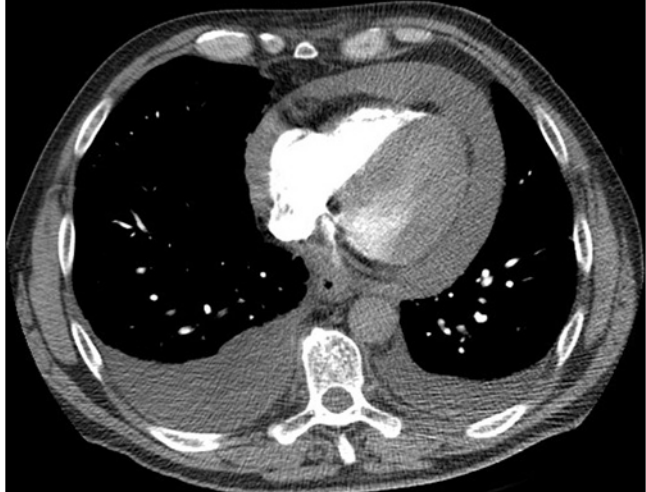
Figure 1. Computed tomography (CT) chest axial view. Large pericardial effusion and moderate bilateral pleural